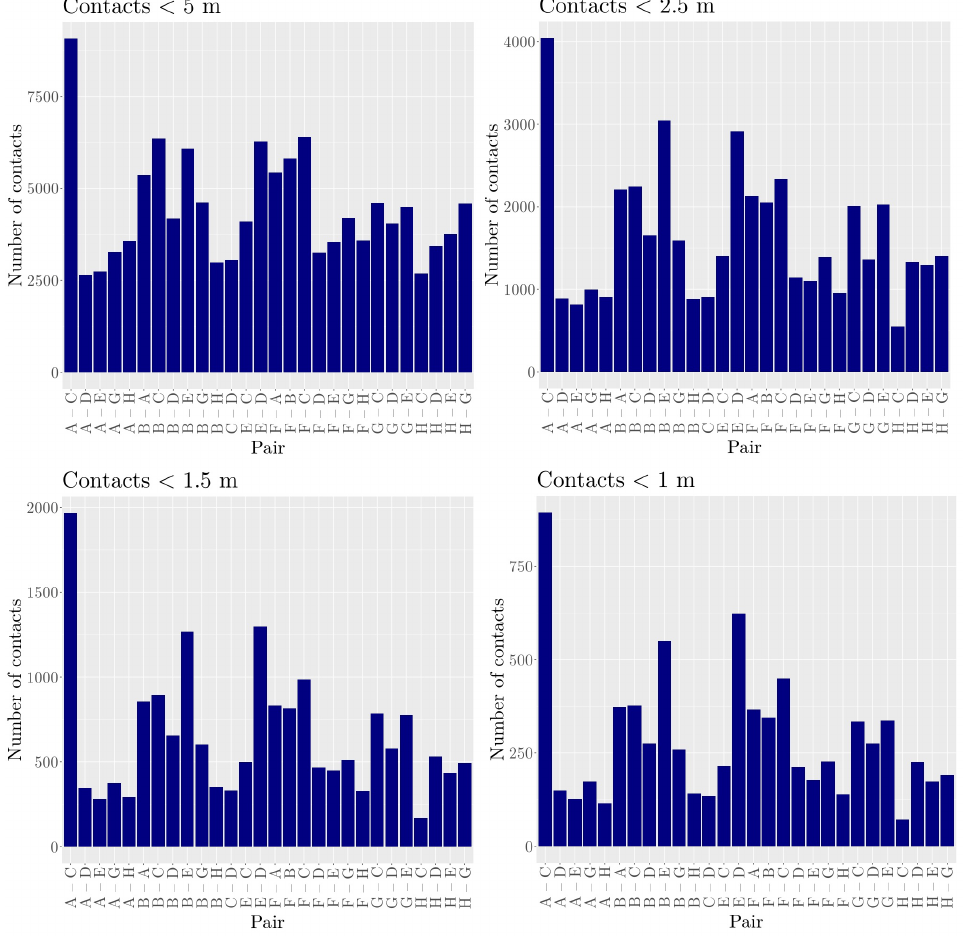
Figure 2. Number of contacts for all dyads. Number of contacts, i.e., time points in minutes, the two animals shared a distance below a threshold of 5 m, 2.5 m, 1.5 m, or 1 m,